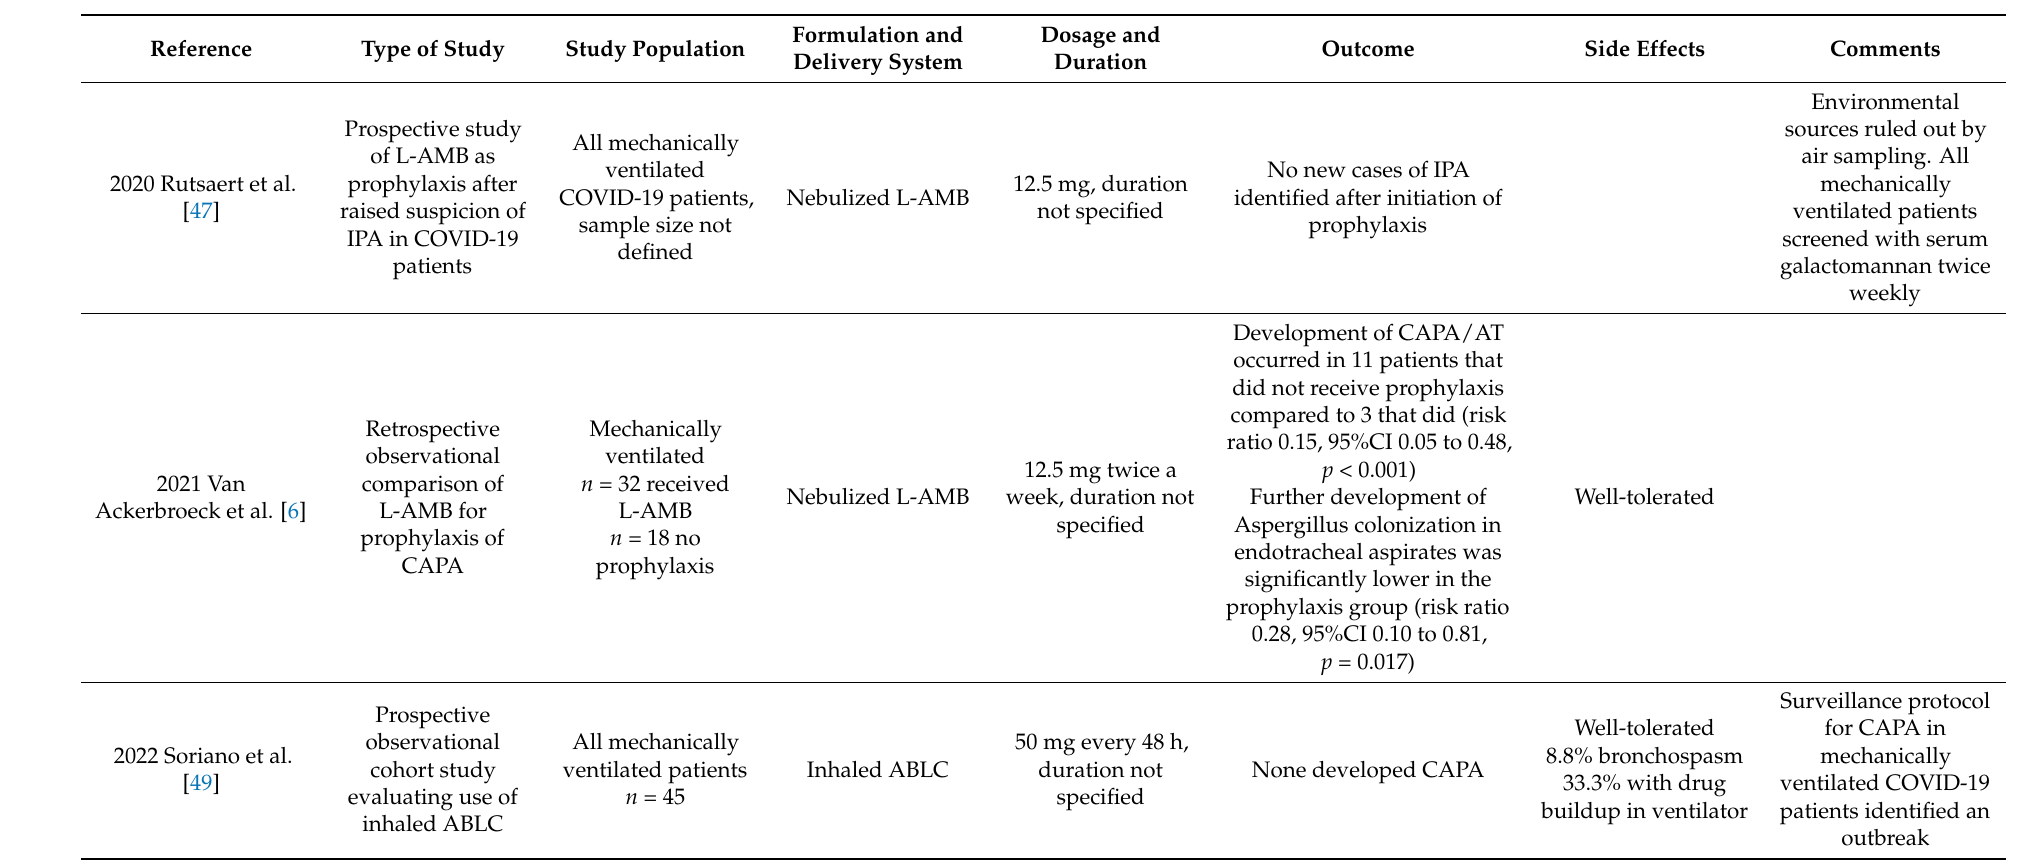
Table 3. Inhaled AMB as prophylaxis for IPA following viral